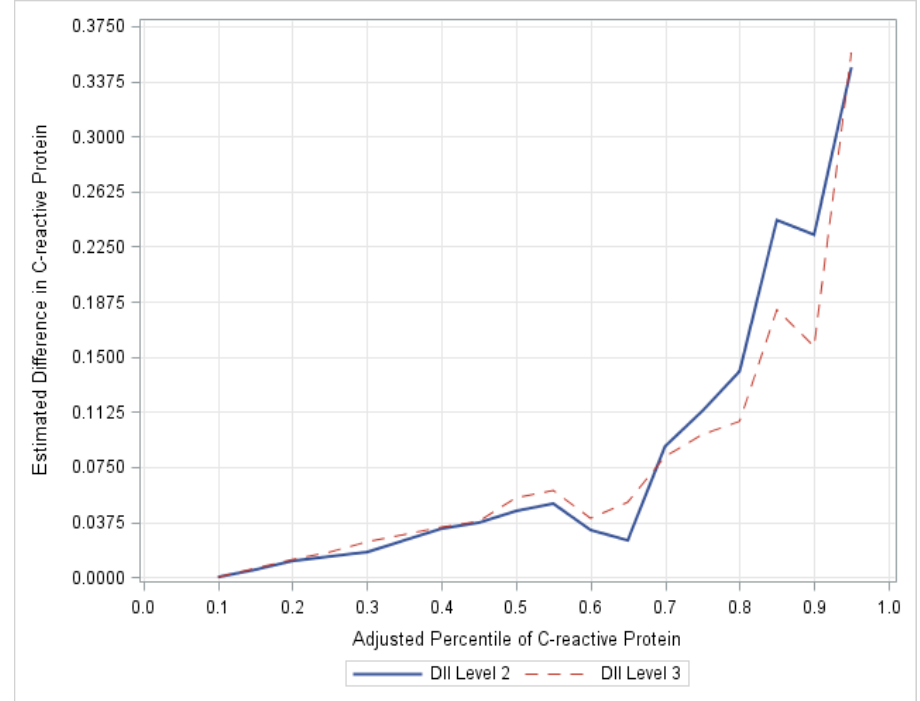
Figure 1. Plot of regression coefficients (C-DII and CRP). The magnitude of the differences in CRP increases at the upper percentiles up to the 85th percentile. CRP for children in C-DII group 2 as compared to C-DII group 1 at the 85th percentile is over 5 times the difference in CRP at the